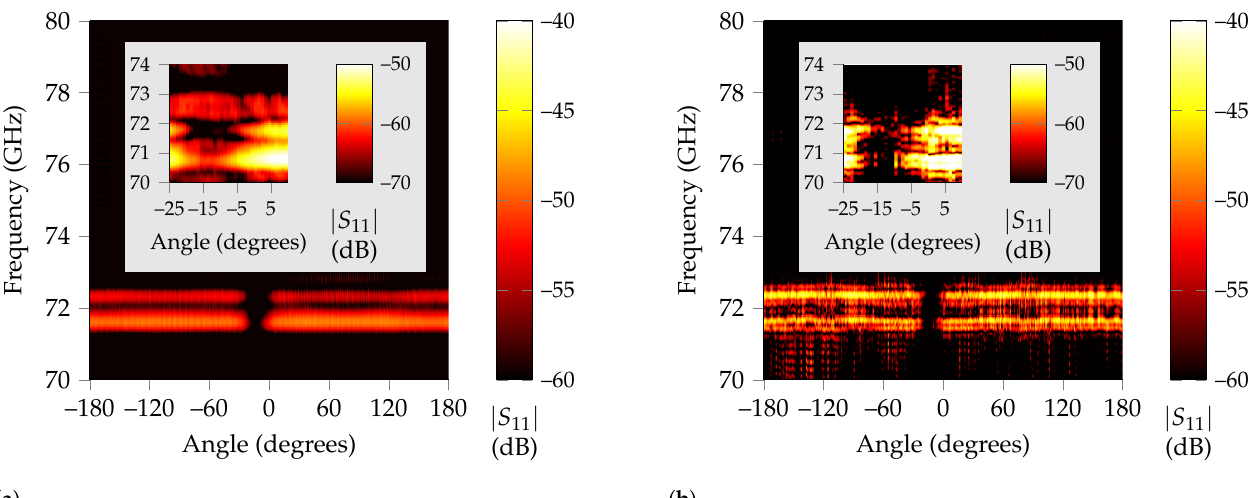
Figure 12. Received power in terms of angle and frequency when a small metallic rod rotates around the high-Q tag. ( a ) Time-gating results for all angles. The deep notch region on the center due to blockage is easily noticeable. ( b ) RPCA extracted tag responses for all rotations. The tag’s resonances present a larger power than the time-gating